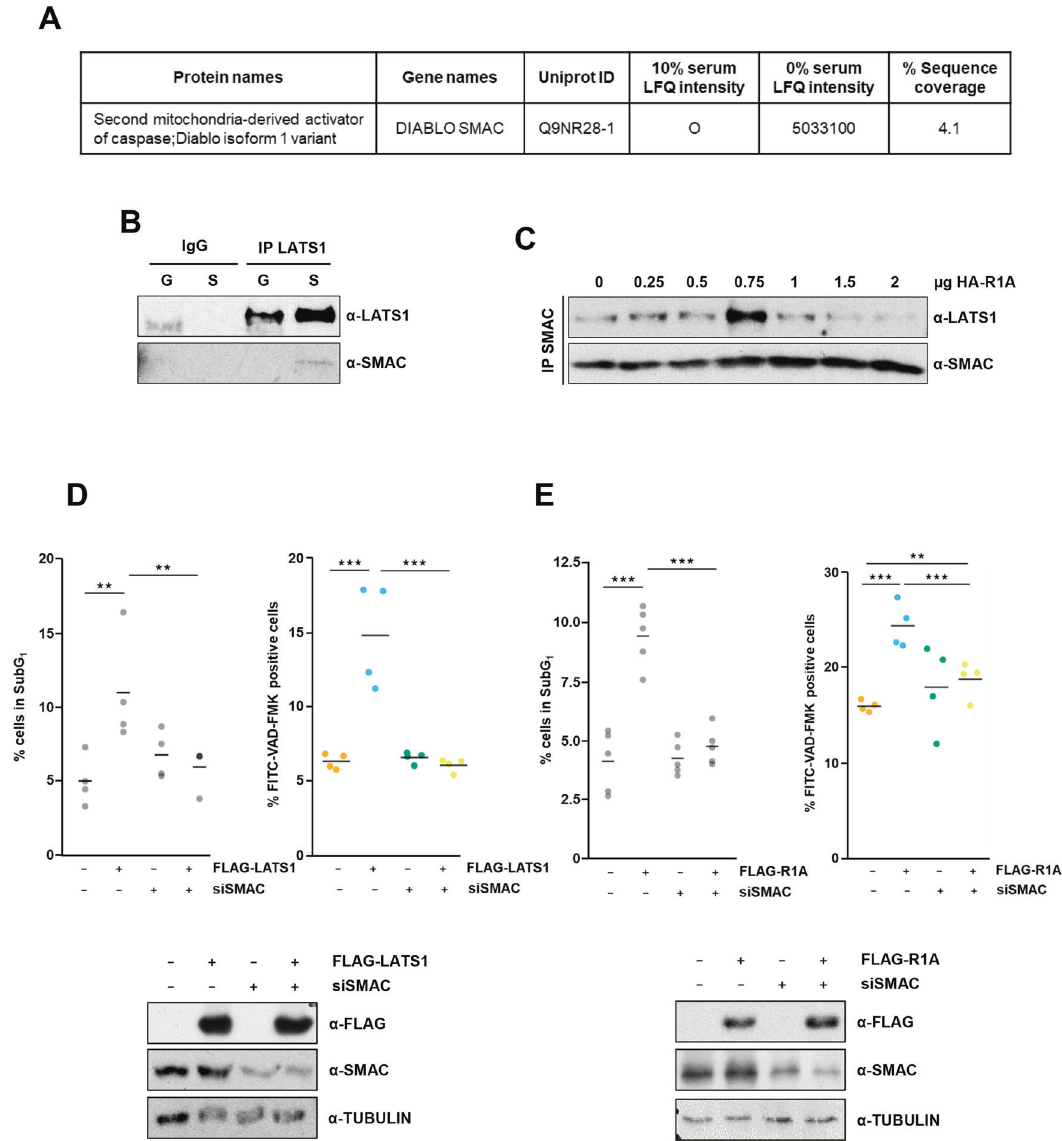
Fig. 1 LATS1-mediated cell death is dependent on SMAC levels. A HEK293 cells transfected with FLAG-LATS1 were lysed and LATS1 interactome was identi fi ed using mass spectrometry. The table shows the results for SMAC protein in LATS1 from MaxQuant search. LFQ (label-free quantitation) intensity is shown for cells cultured in either complete media (10% serum-supplemented media) or serum deprived (0% serum-supplemented media). B Endogenous interaction of LATS1 with SMAC in HeLa cells assessed by co-immunoprecipitation upon proapoptotic serum-deprived conditions. Levels of immunoprecipitated LATS1 and SMAC are shown. Normal IgG was used as negative control. C Endogenous interaction of LATS1 with SMAC in MCF7 cells upon increasing RASSF1A (R1A) expression and serum deprivation. Levels of immunoprecipitated SMAC and LATS1 are shown. D Left: percentage of HeLa cells in subG 1 phase upon LATS1 overexpression and SMAC downregulation in serum-deprived conditions determined by fl ow cytometry after PI staining ( n = 3). Right: Percentage of HeLa cells showing Caspase 3 activation upon LATS1 overexpression and SMAC downregulation in serum-deprived conditions determined by fl ow cytometry after FITC-VAD-FMK staining ( n = 4). Lower panel: FLAG-LATS1 overexpression and SMAC downregulation measured by western blot. TUBULIN was used as loading control. E Left: Percentage of MCF7 cells in subG 1 phase upon RASSF1A (R1A) overexpression and SMAC downregulation in serum-deprived conditions determined by fl ow cytometry after PI staining ( n = 4). Right: Percentage of MCF7 cells showing Caspase 3 activation upon RASSF1A (R1A) overexpression and SMAC downregulation in serum-deprived conditions determined by fl ow cytometry after FITC-VAD-FMK staining ( n = 4). Lower panel: FLAG-RASSF1A (FLAG-R1A) overexpression and SMAC downregulation measured by western blot. TUBULIN was used as loading control. Statistical analysis: t test p ≤ 0.1*; p ≤ 0.05**; p ≤